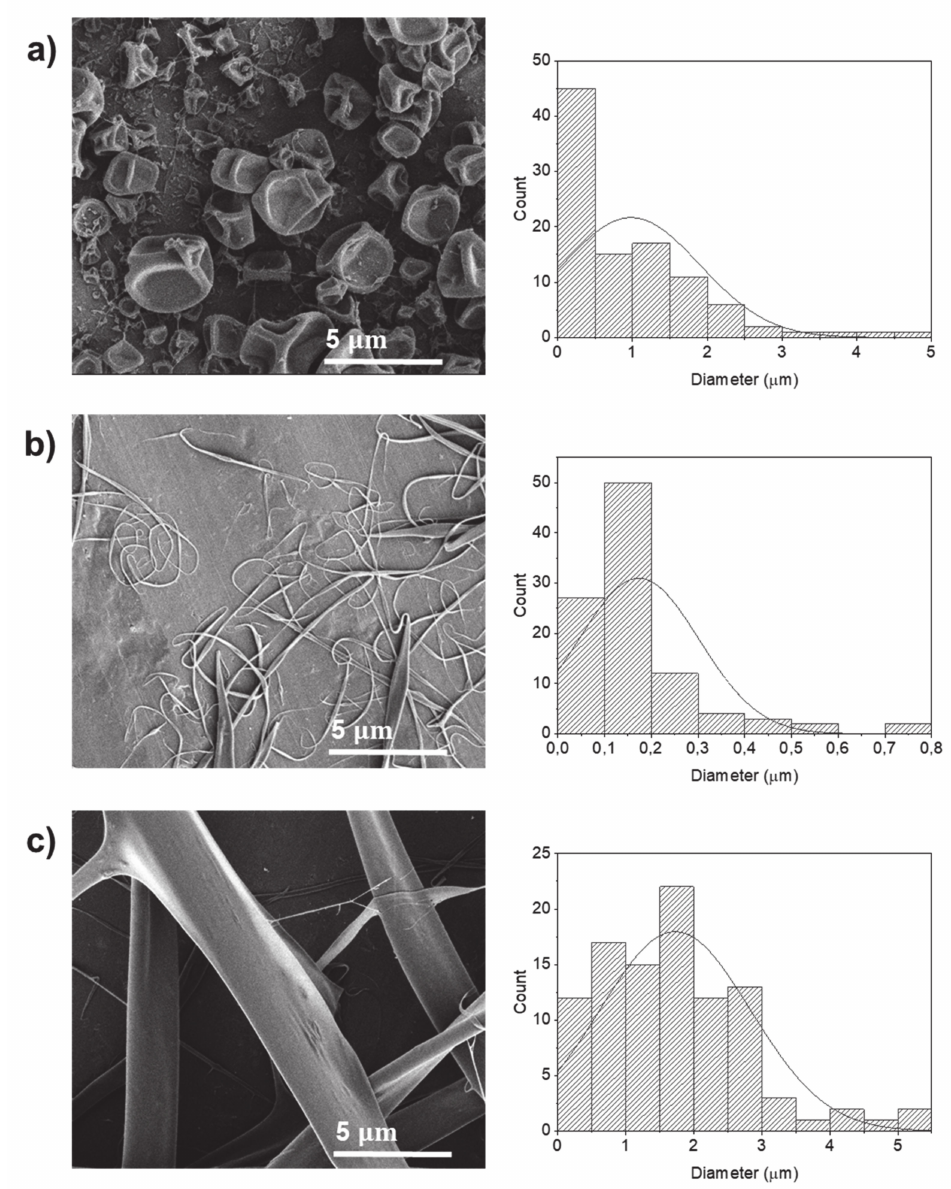
Figure 5. SEM images of electrosprayed potato protein particles using hexafluoro-2-propanol (HFIP) as a solvent and respective histograms displaying their diameter distribution. Samples prepared at potato protein concentrations of ( a ) 5% w / v , ( b ) 10% w / v and ( c ) 20% w / v .